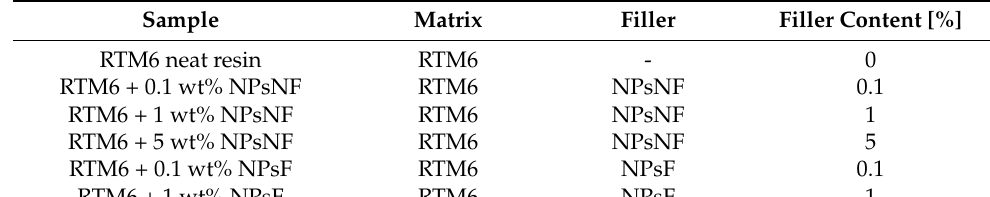
Table 1. Composition of the manufactured nanocomposites.